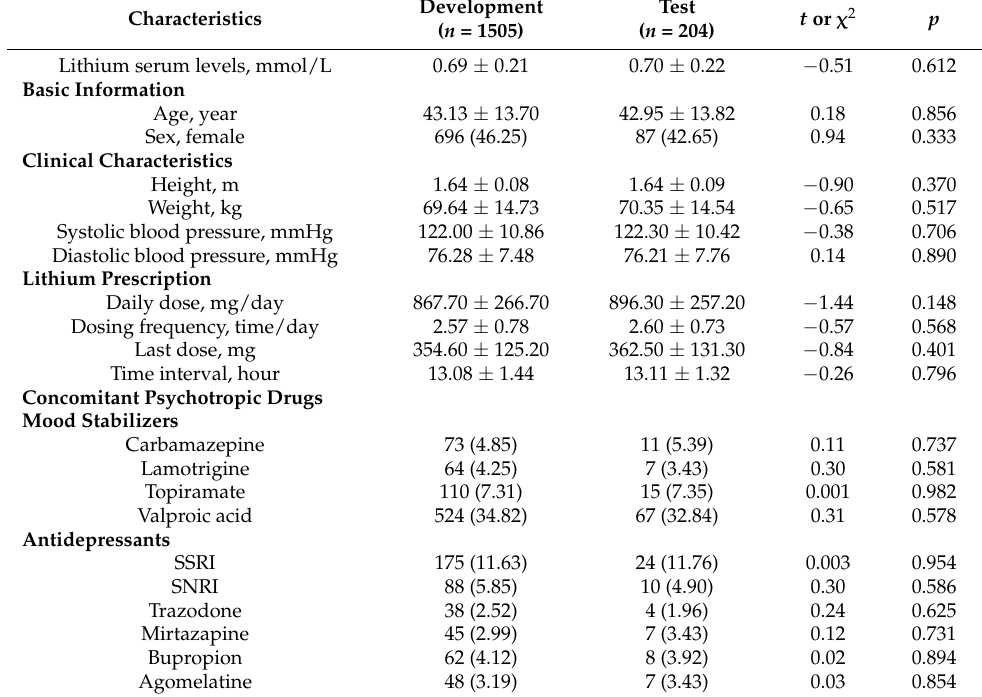
Table 1. Characteristics of lithium-treated patients, comparing inpatient development data and inpatient test